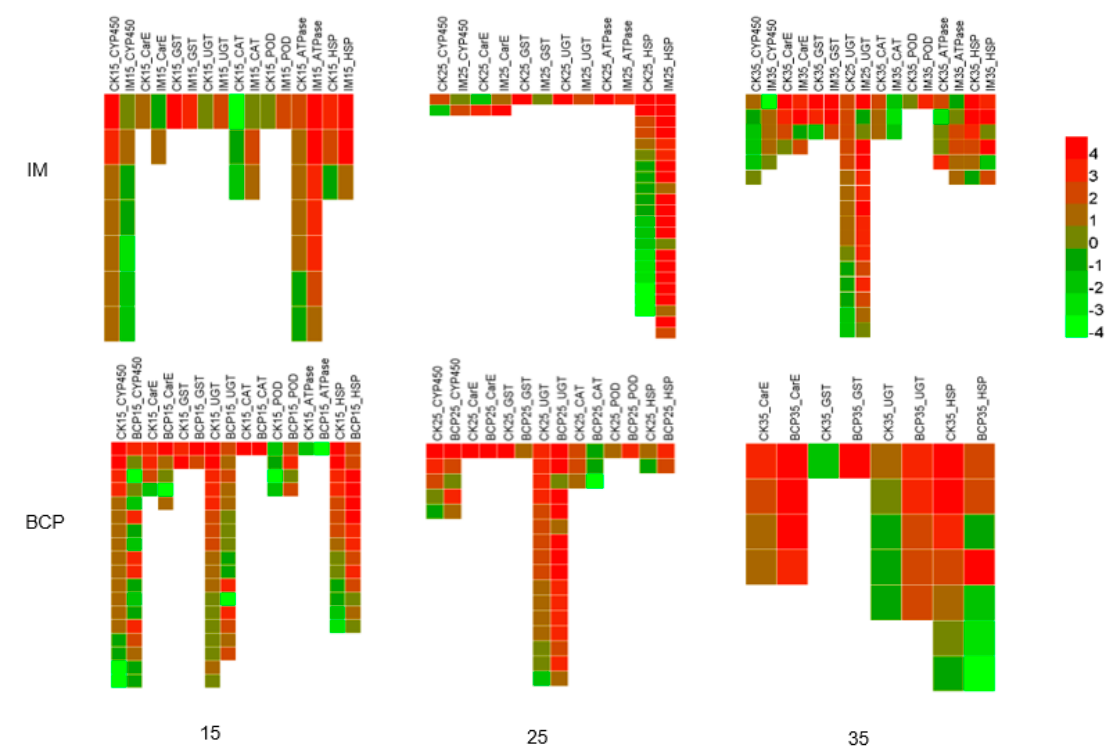
Figure 5. The pattern of temperature effect related differentially expressed transcripts (DETs). These related genes included detoxification enzyme cytochrome P450 (CYP450), glutathione S-transferase (GST), carboxylesterase (CarE), UDP-glucuronyltransferase (UGT), antioxidant enzyme superoxide dismutase (SOD), catalase (CAT), and peroxidase (POD) and adenosine triphosphatase (ATPase) heat shock proteins (HSPs). Compared to the blank control, the enzymes labeled in the red box are associated with up-regulation. The green one means that it was associated with down-regulation.